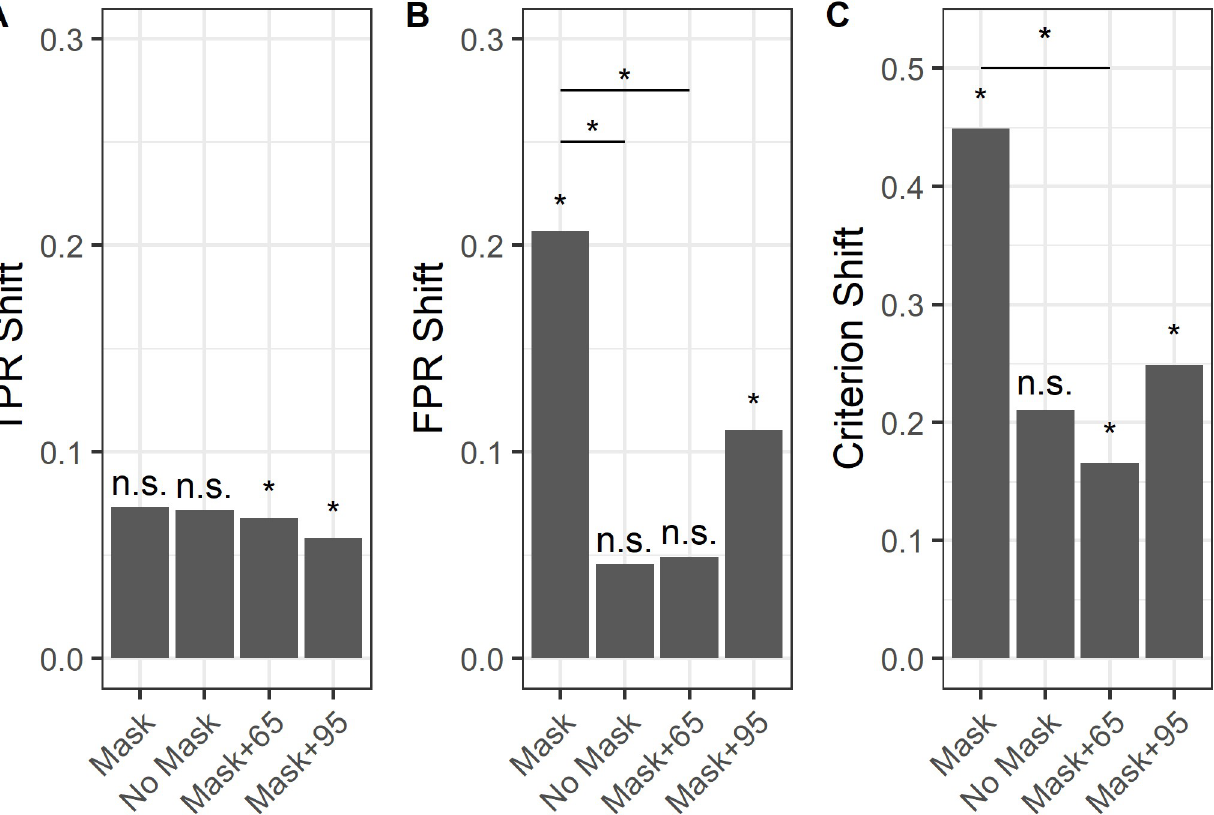
Fig 4. Panel A compares shifts in True Positive Rates (TPR) across Study 1 and 2 conditions. Panel B compares shifts in False Positive Rate (FPR) across Study 1 and 2 conditions. Panel C compares Criterion shifts across Study 1 and 2 conditions. The Mask and No Mask bars are the experimental conditions from Study 1. The Mask+65 and Mask+95 correspond to the 65- and 95-algorithm conditions in Study 2, respectively. Significant ( p < 0.05) shifts within a condition are denoted by an asterisk ( � ) and non-significant shifts are indicated by n.s. over the bars. Significant ( p < 0.05) shifts across conditions and studies are indicated by horizontal lines and asterisks ( �